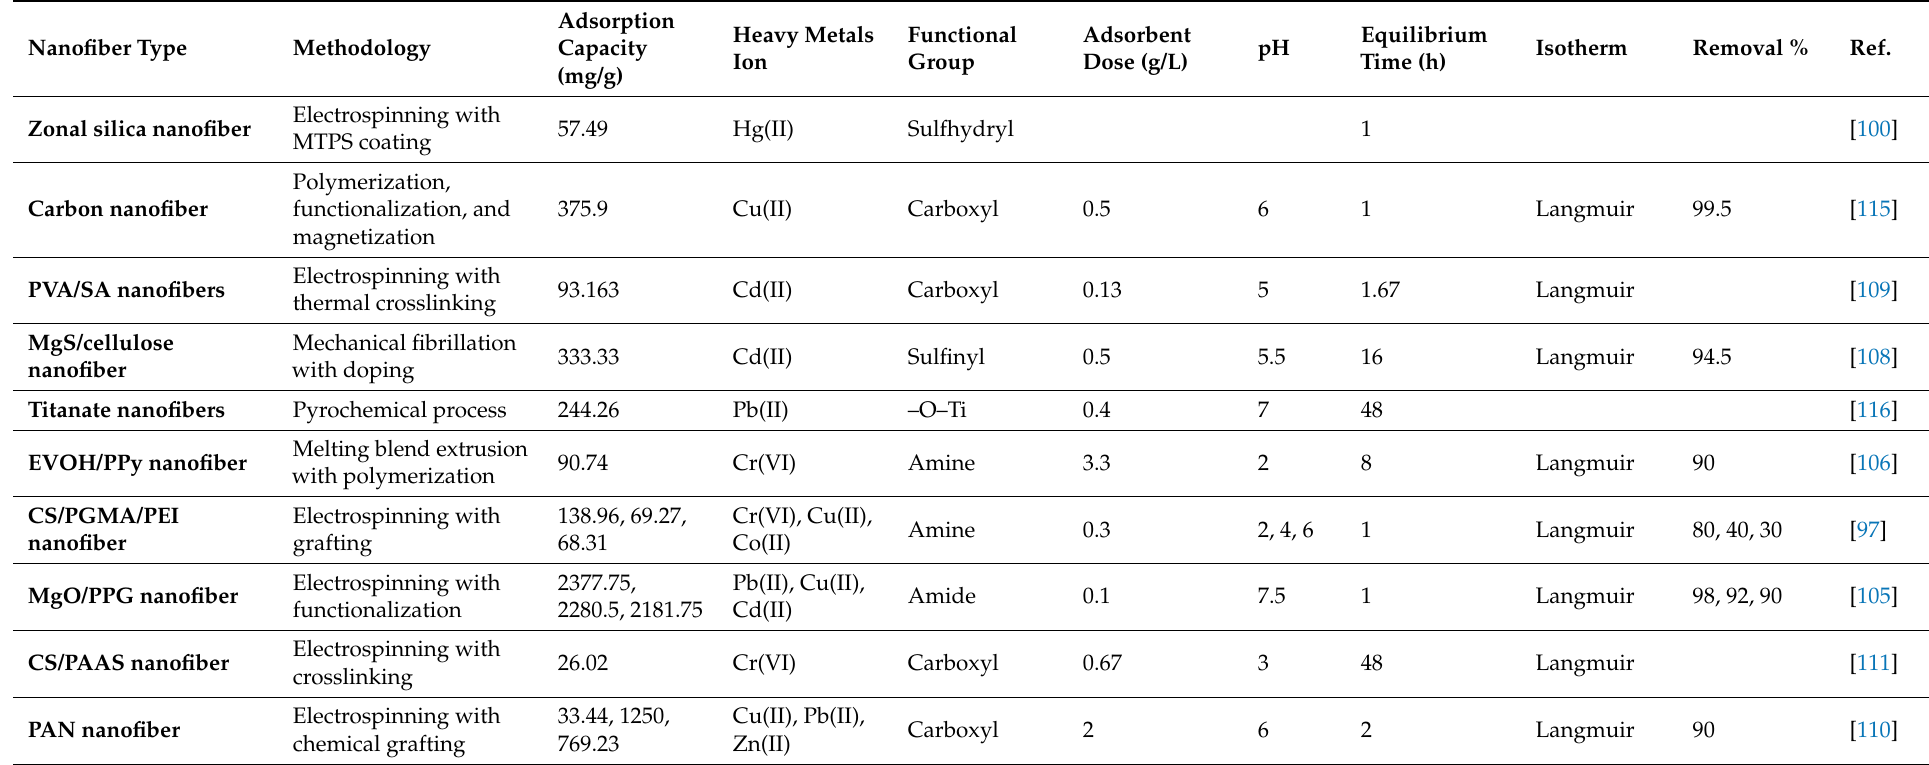
Table 3. A summary of heavy-metal remediation using